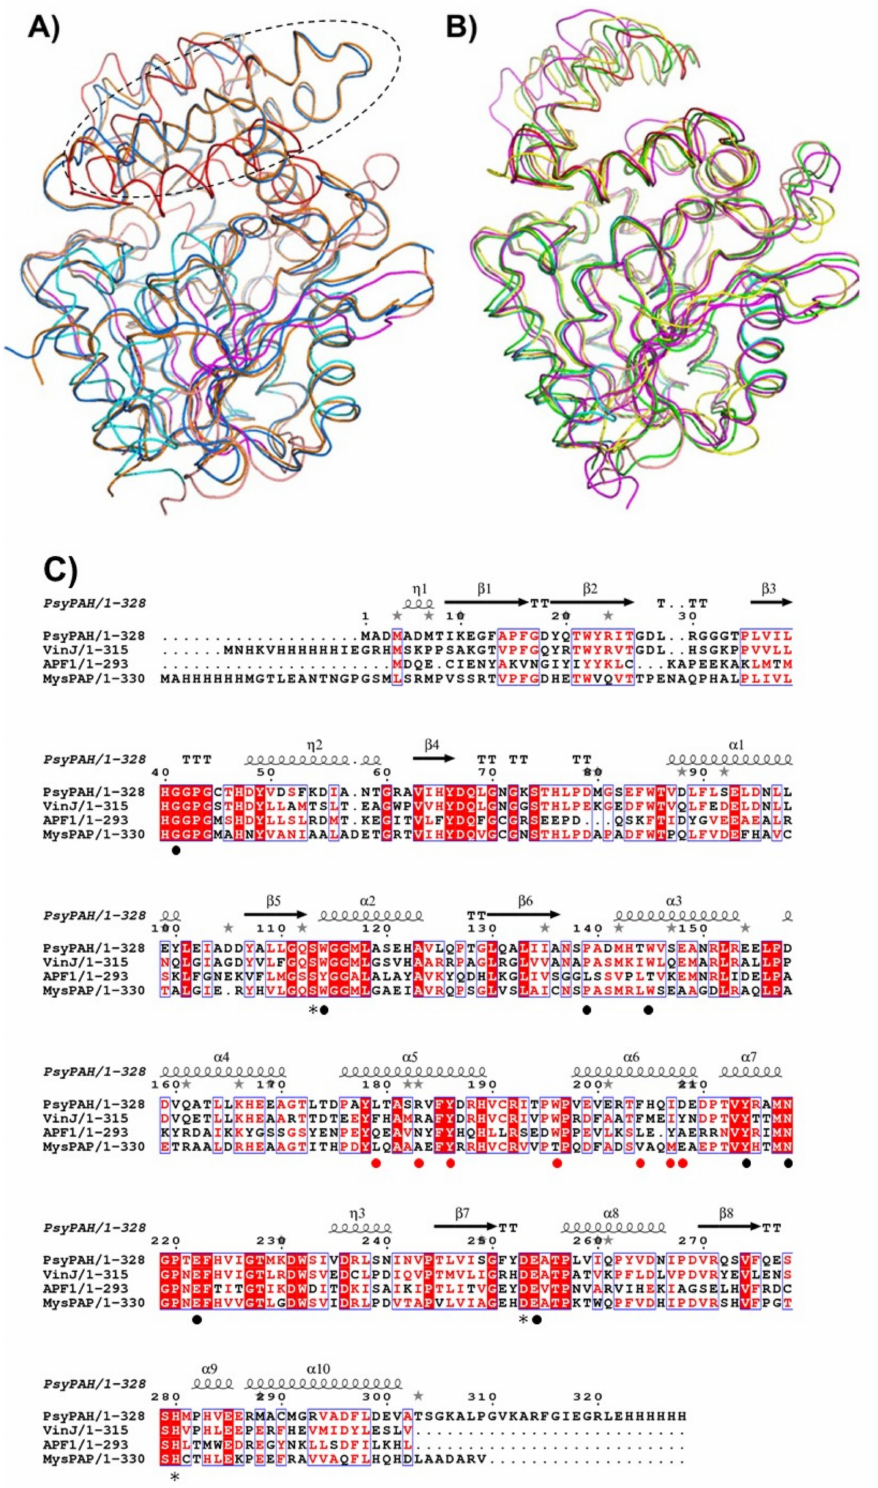
Figure 4. ( A ) Superposition of PsyPAH with “real” PAPs belonging to Xanthomonas campestris (XcPAP, PDB 1AZW) and from Serratia marcescens (SmPAP, PDB 1QTR). ( B ) Superposition of PsyPAH, amidohydrolase VinJ (PDB 3WMR), APF1 from Thermoplasma acidophilum (PDB 1MTZ), and putative uncharacterized PAP from Mycobacterium smegmatis (MysPAP, PDB 3NWO). ( C ) Sequence alignment of PsyPAH, VinJ, APF1, and MysPAP shown in panel B. Residues comprising the SBGs (red circles) or catalytic triad (asterisks)/catalytic cleft (black circles) are